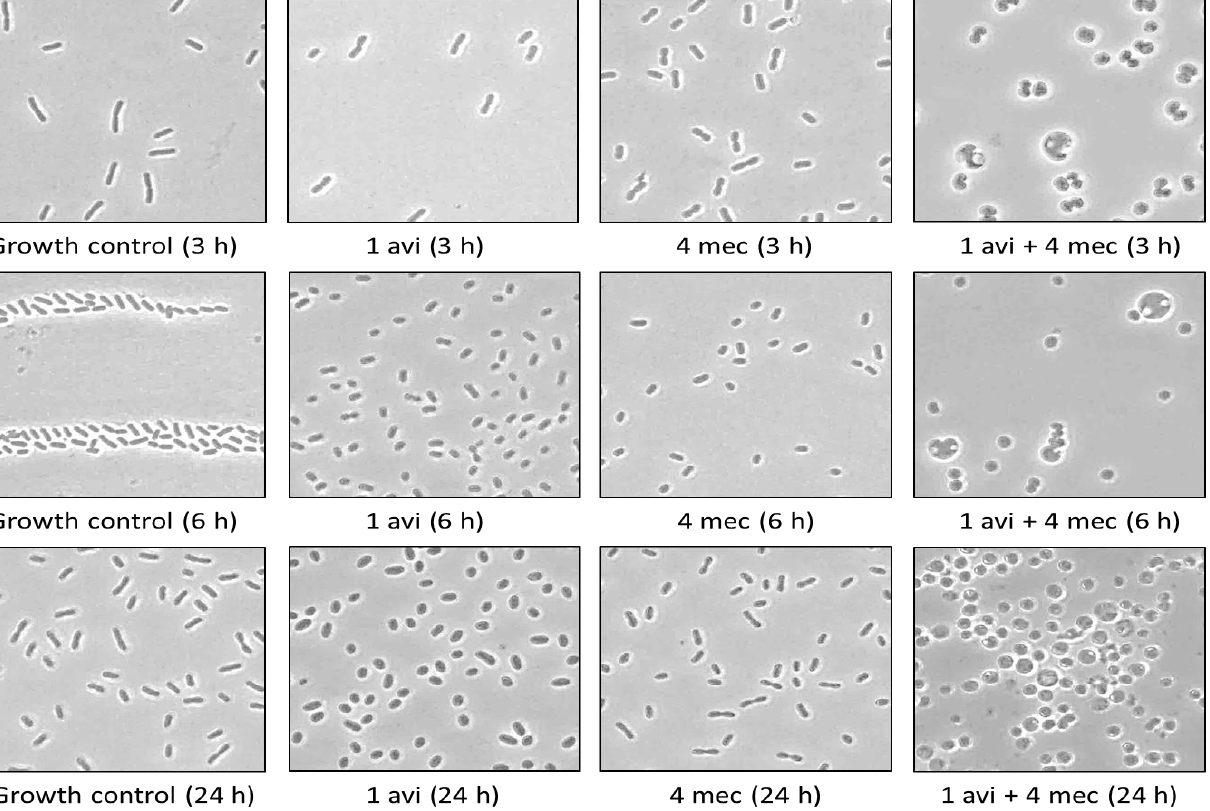
Figure 3. Spherical structures of the K. pneumoniae strain KP7 observed in vitro. Phase-contrast microscopy (1000× magnification) of KP7 cells in four treatment groups, including growth control, 1 mg/L avibactam (1 AVI), 4 mg/L mecillinam (4 MEC) and 1 mg/L avibactam combined with 4 mg/L mecillinam (1 AVI + 4 MEC). Images are from time points 3, 6 and 24 h.